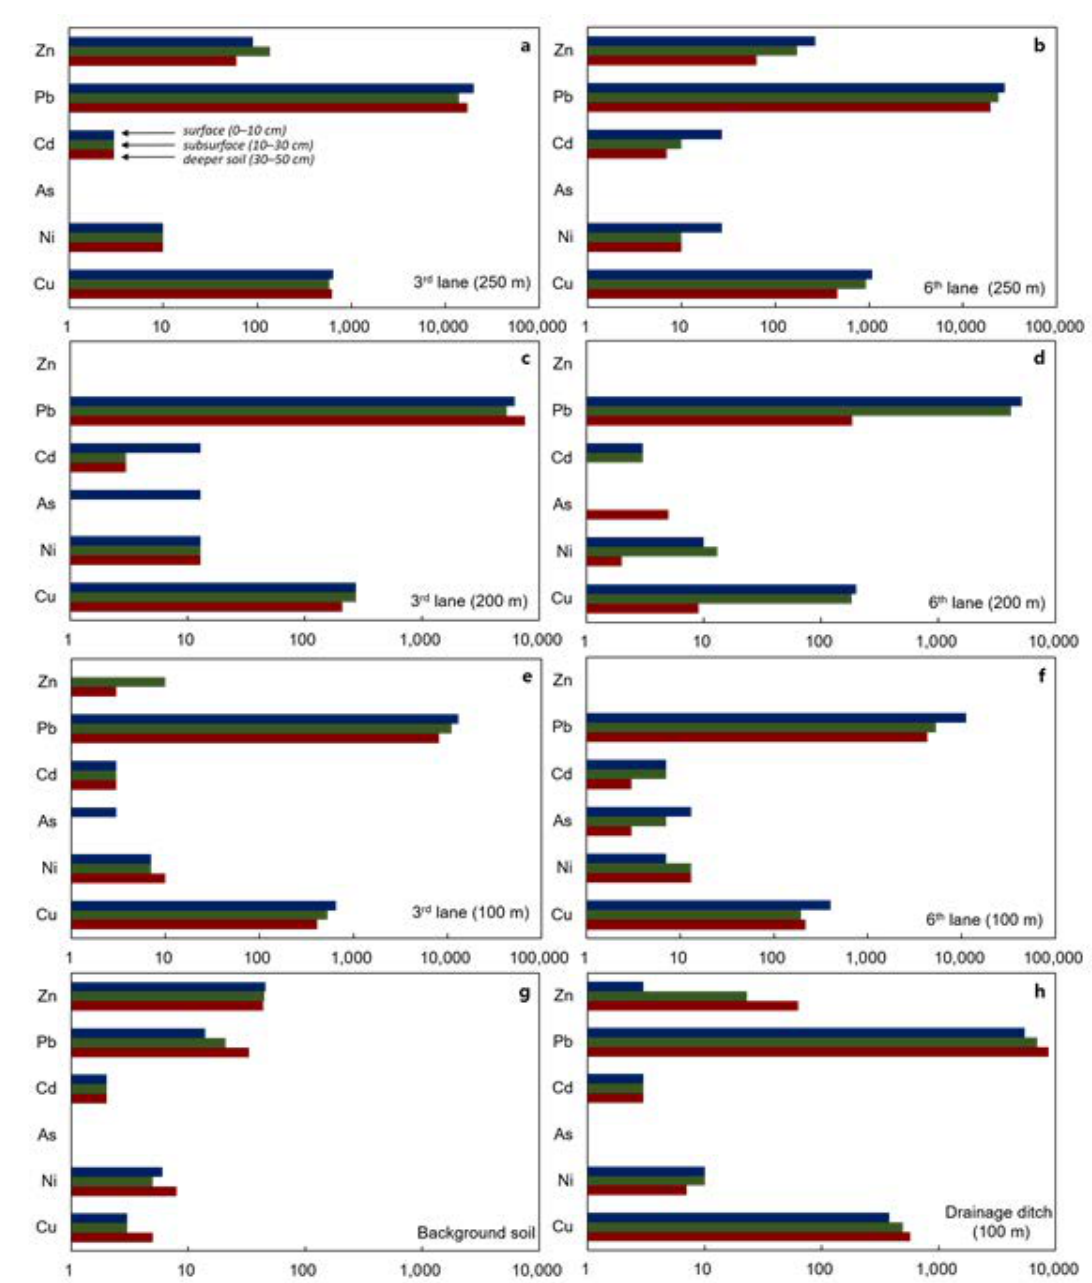
Figure 2. The Zn, Pb, Cd, As, Ni, and Cu concentration (ppm) of soils from ( a , c , e ) 3rd and ( b , d , f ) 6th shooting lane with ( g ) background and ( h ) drain ditch for each transect. The blue, green, red bars are indicative of vertical soil profiles of surface (0–10 cm), subsurface (10–30 cm), and the deeper soil (30–50